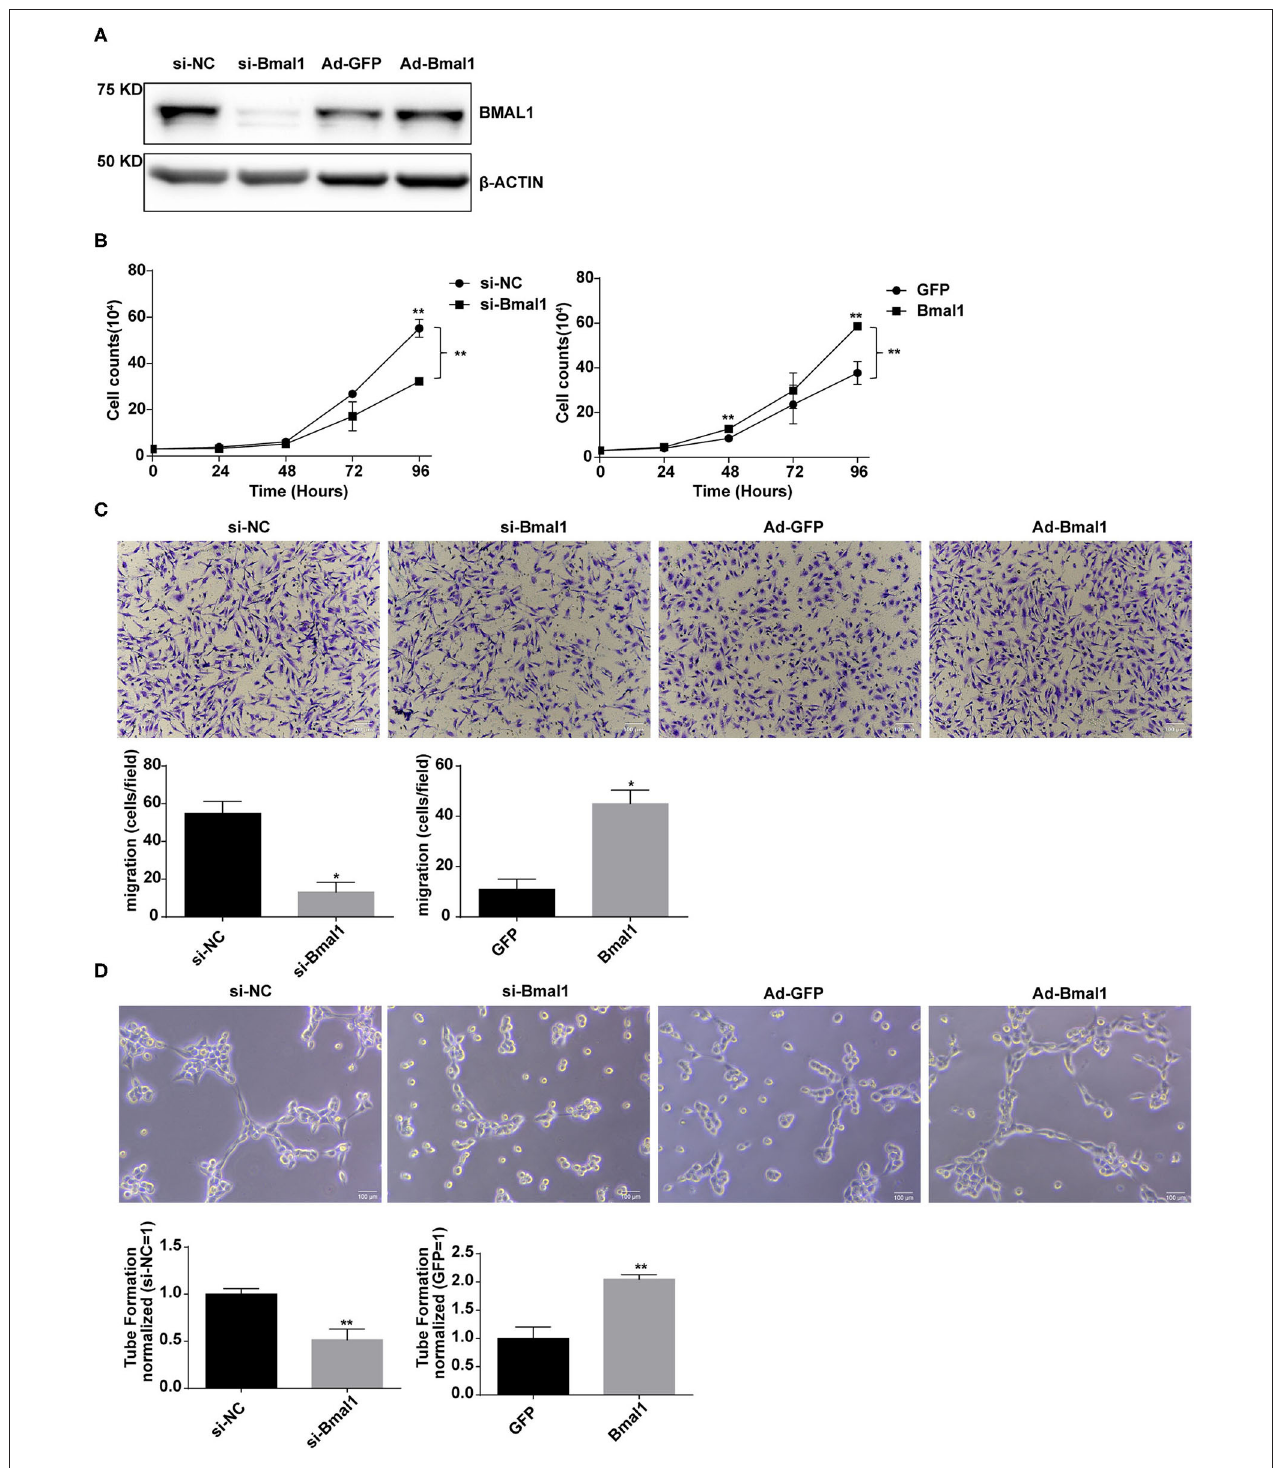
FIGURE 6 | Bmal1 promotes the proangiogenic activity of endothelial cells. (A) Knockdown and overexpression effect of Bmal1 in human umbilical vein endothelial cells (HUVECs). Bmal1 protein levels were evaluated via western blotting assay. (B) Cell proliferation was measured by cell counting in HUVECs. Data are presented as mean ± SEM (unpaired t -test and two-way ANOVA with post-hoc Sidak test). ** p < 0.01 si-Bmal1 vs. si-NC; ** p < 0.01 Bmal1 vs. GFP. (C) Cell migration measured by transwell in HUVECs. Data are presented as mean ± SEM (unpaired t -test). * p < 0.05 si-Bmal1 vs. si-NC; * p < 0.05 Bmal1 vs. GFP. (D) Endothelial tube formation in matrigel in HUVECs. Data are presented as mean ± SEM (unpaired t -test). ** p < 0.01 si-Bmal1 vs. si-NC; ** p < 0.01 Bmal1 vs. GFP. Each expreiment was repeated 3 independent times.